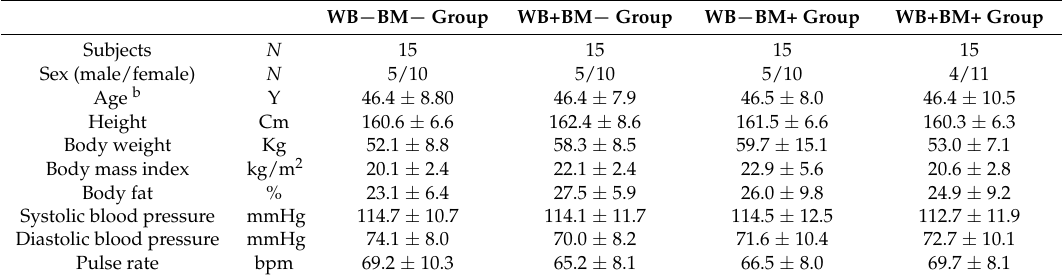
Table 1. Baseline characteristics of subjects. a